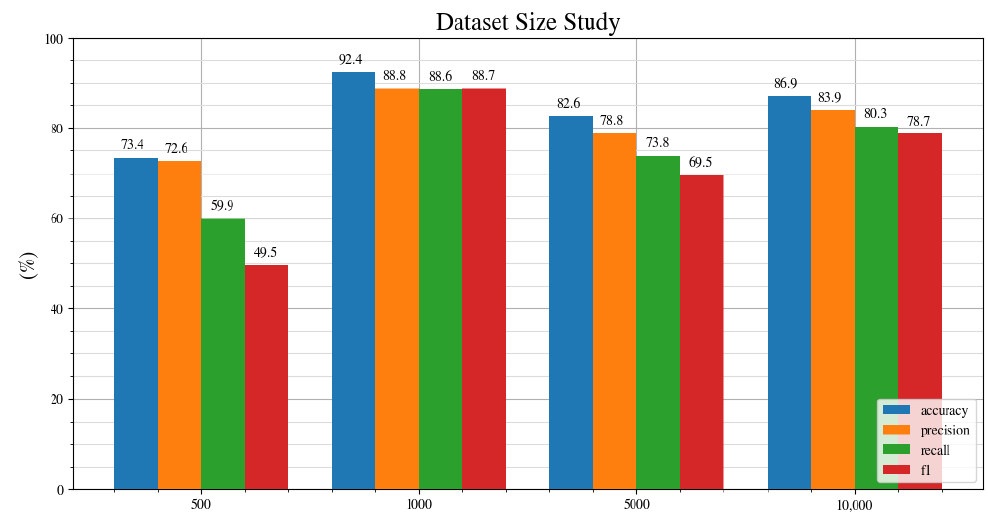
Figure 8. Dataset size study for datasets of 500, 1000, 5000, and 10,000 images.